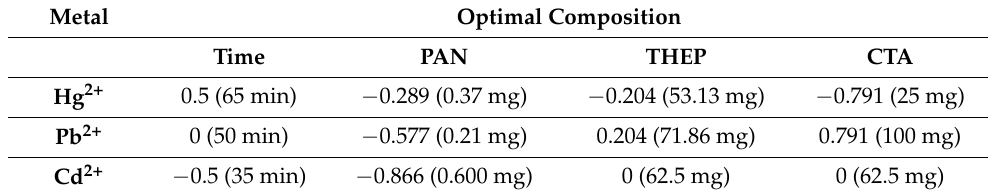
Table 3. Summary of the optimization results for the membranes prepared with PAN and THEP using M1 in the determination of Hg(II). Pb(II). and Cd(II). Coded and real values of the variables are indicated.